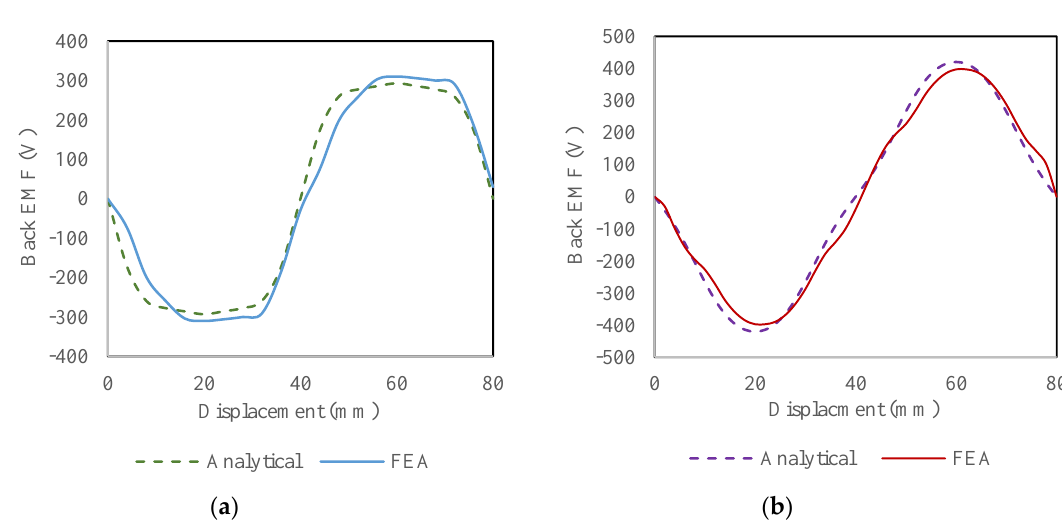
Figure 28. Induced Back EMF Validation of ( a ) TPMLM-NS; ( b ) TPMLM-S.